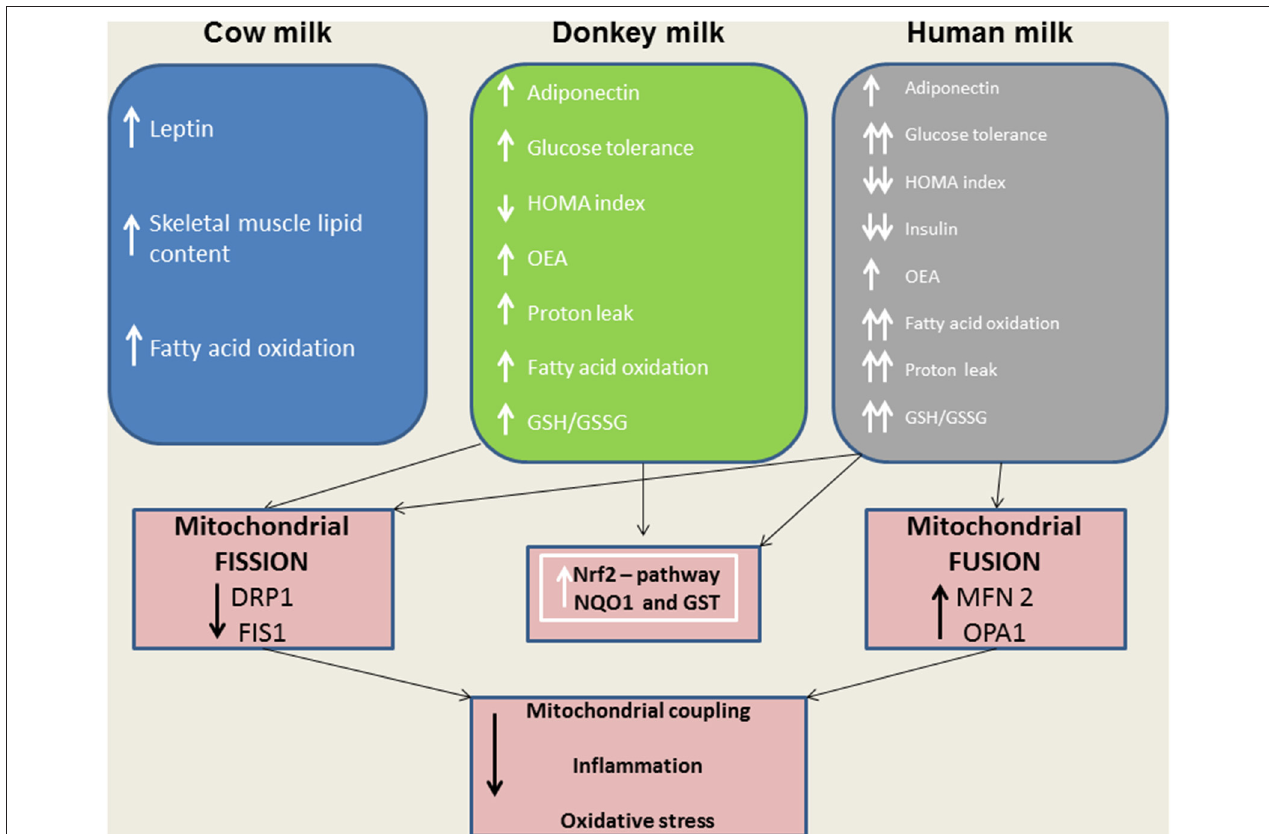
FIGURE 9 | A model depicting the effects of distinct milk supplementation. The beneficial effects elicited by HM and DM are, at least in part, mediated by their ability to diminish mitochondrial ROS emission, and to modulate mitochondrial uncoupling and dynamics as well as Nrf2 activation.